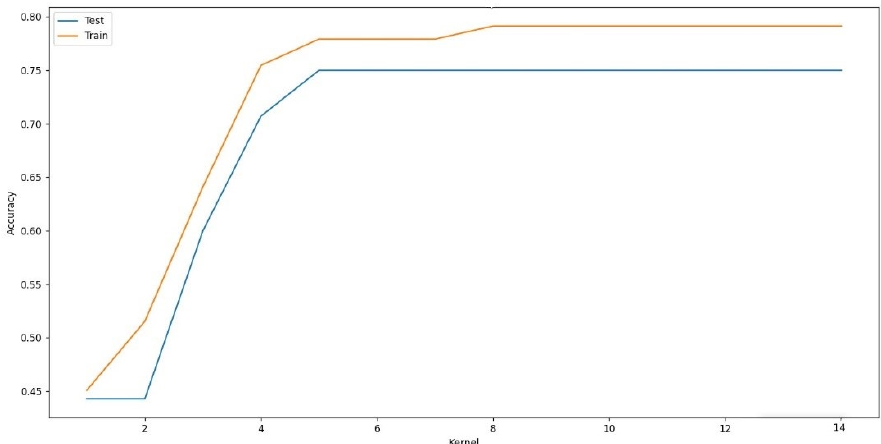
Figure 5. Accuracy of the model in different kernels based on demographic data.